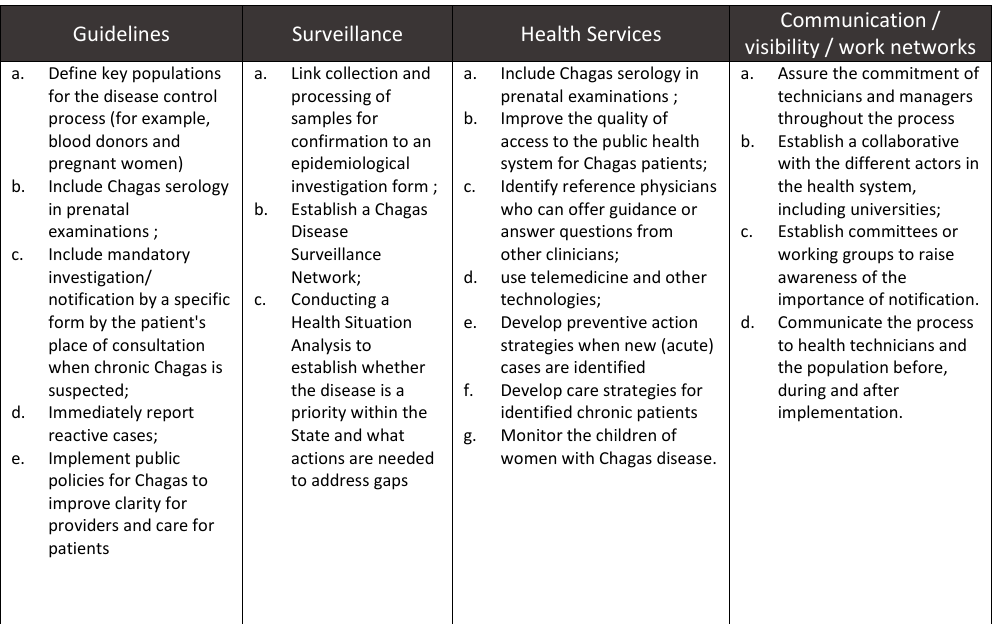
Figure 4. Recommendations and lessons learned from the implementation of notification of chronic Chagas disease in Goiás.